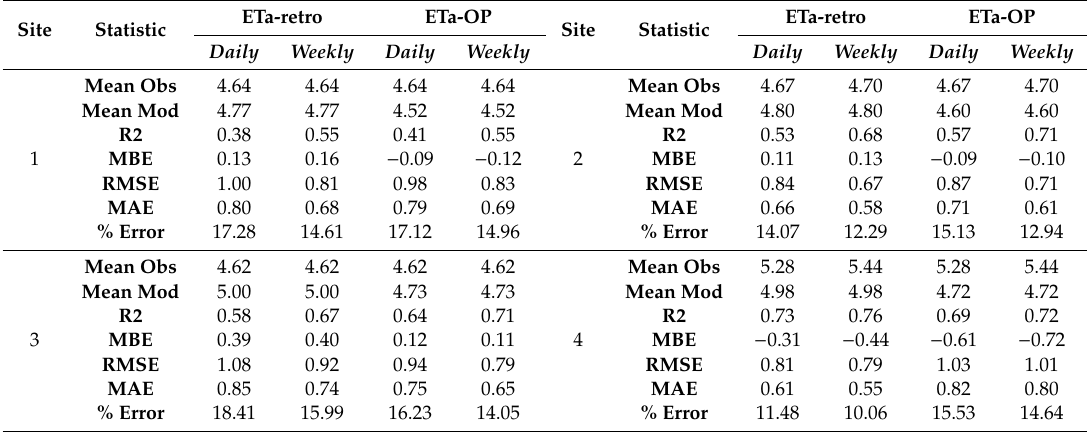
Table 1. Statistical metrics of operational and retrospective model performance (ET a -OP and ET a -retro) for estimating ET a (mm day − 1